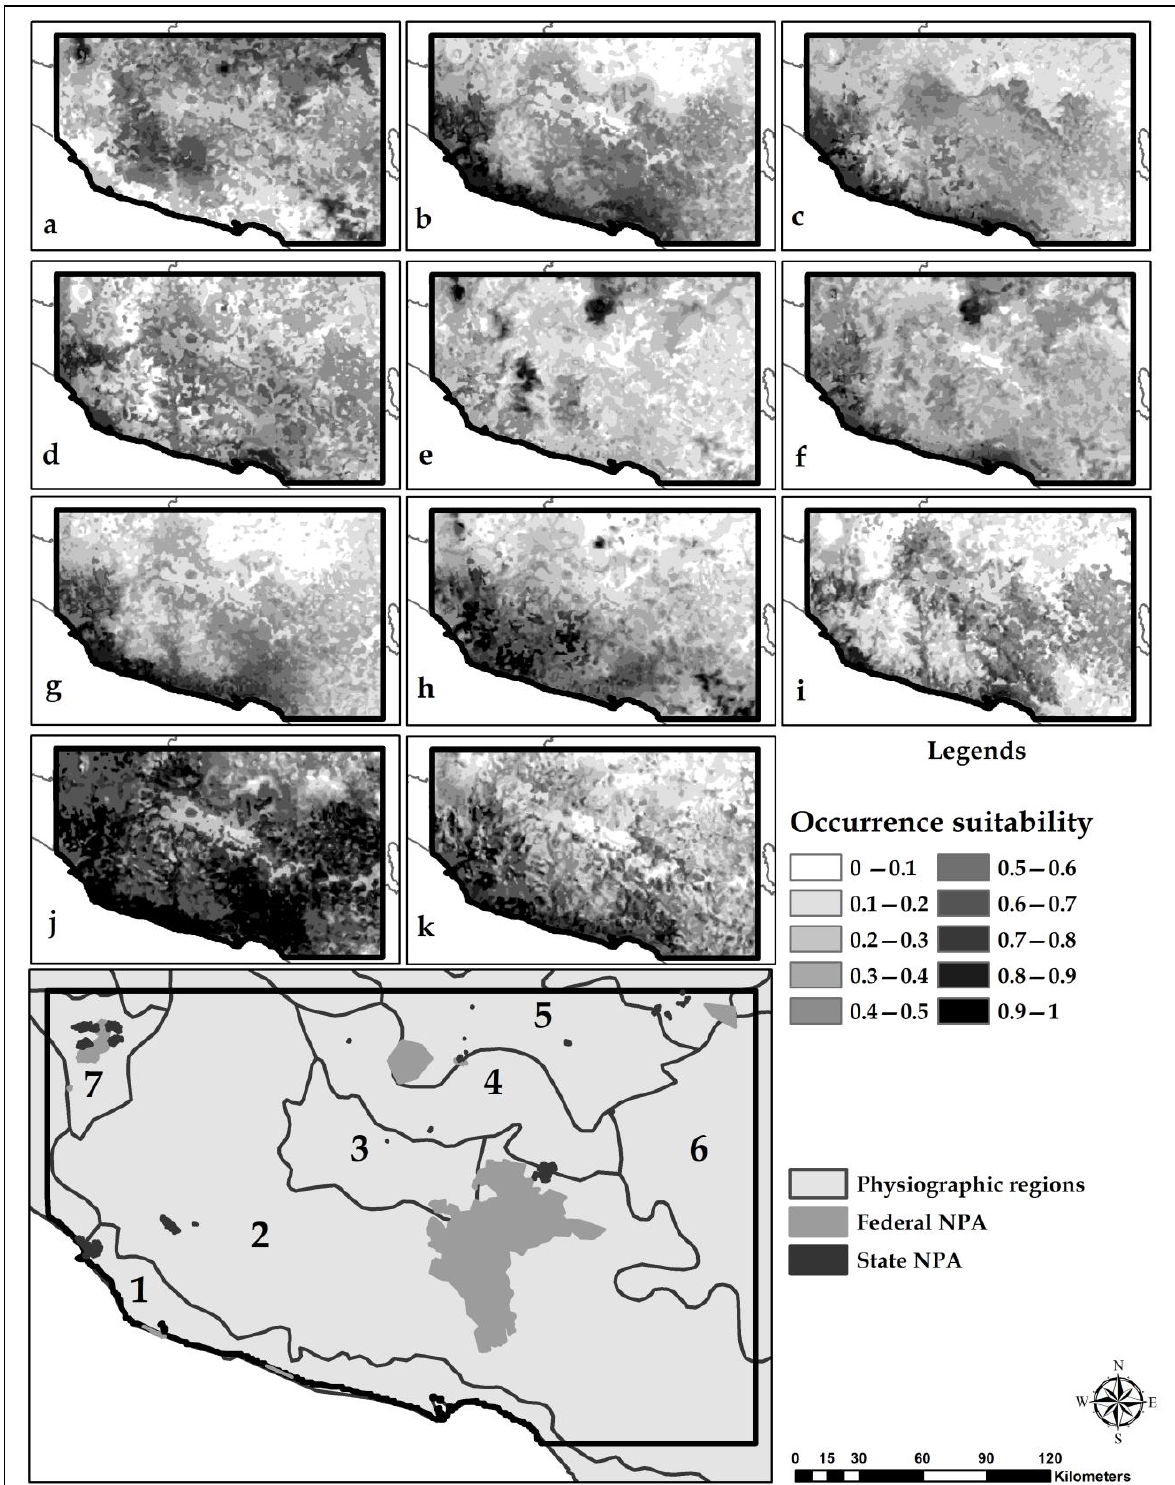
Figure A3. Habitat suitability models for 11 carnivore species. ( a ) Bassariscus astutus , ( b ) Nasua narica , ( c ) Procyon lotor , ( d ) Conepatus leuconotus , ( e ) Canis latrans , ( f ) Urocyon cinereoargenteus , ( g ) Leopardus pardalis , ( h ) Leopardus wiedii , ( i ) Herpailurus yagouaroundi , ( j ) Puma concolor and ( k ) Panthera onca . Physiographic provinces: (1) Costas del Sur, (2) Cordillera Costera del Sur, (3) Depresión de Tepalcatepec, (4) Escarpa Limítrofe del Sur, (5) Neovolcánica Tarasca, (6) Depresión del Balsas, and (7) Chapala.